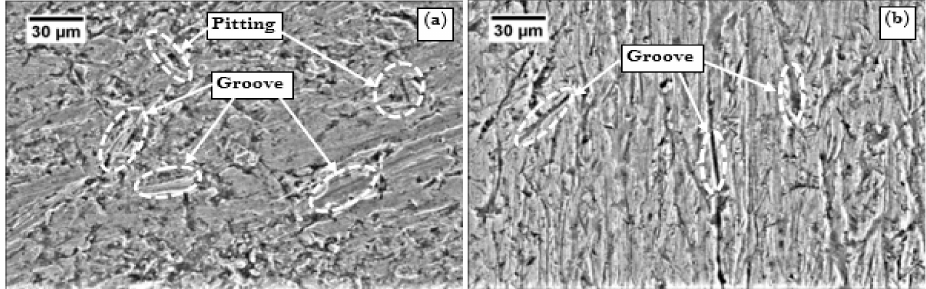
Figure 11. Abraded surfaces of: ( a ) untreated 30MnCrB4 Steel {UT} and ( b ) conventional heat-treated (900 ◦ C / 0.67 h, water-quenched) + deep cryogenic-treated ( − 185 ◦ C / 12 h) 30MnCrB4 steel